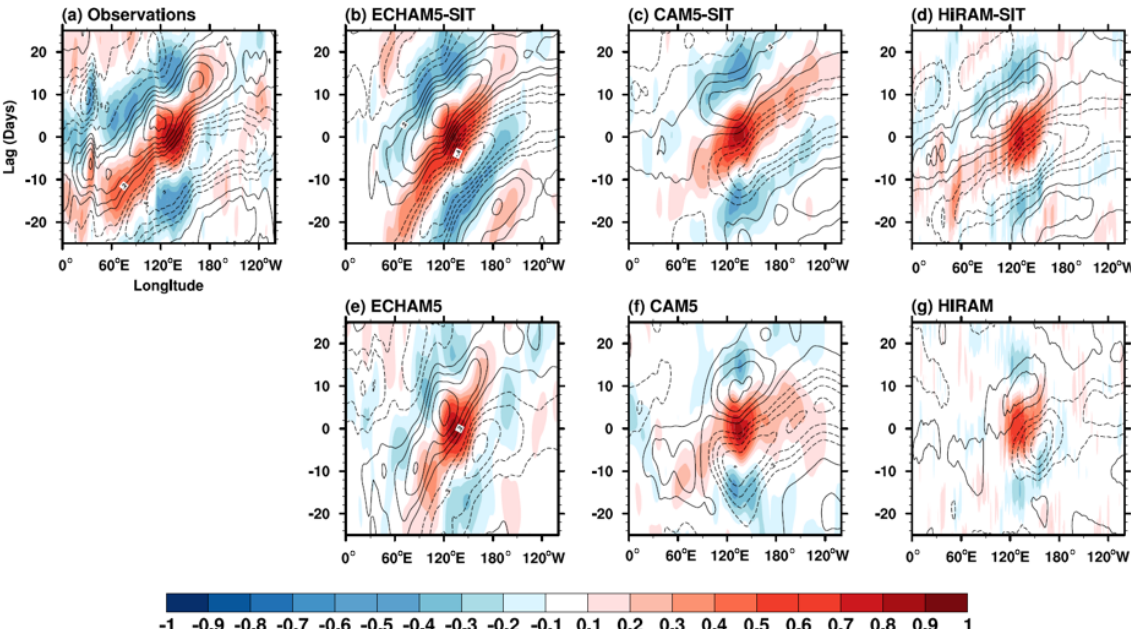
Figure 2. The 10 ◦ S–10 ◦ N averaged lag–longitude diagrams of intraseasonal precipitation (shading) and 10m zonal wind (contour) corre- lated against precipitation (for 10 ◦ S–5 ◦ N, 120–150 ◦ E) from (a) observations and simulations using the (b–d) coupled and (e–g) uncoupled AGCM. The contour interval is